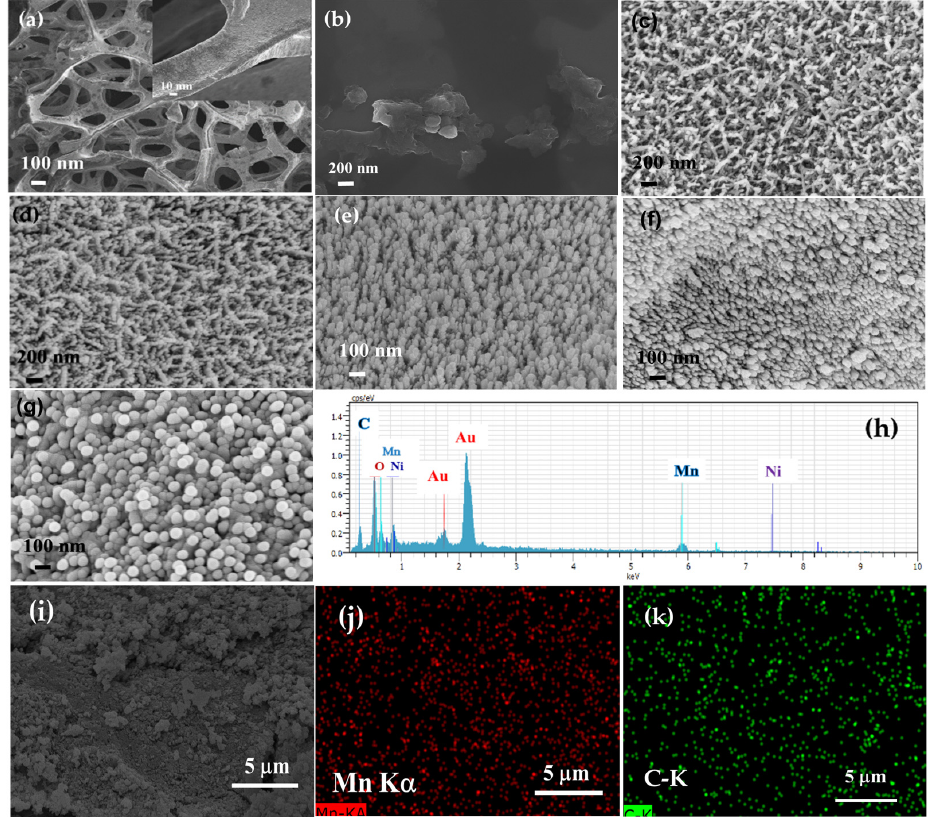
Figure 1. FESEM images of Ni foams ( a ), graphene/Ni foams ( b ), MnO 2 /graphene/Ni electrode (1 mA cm − 2 ( c )), MnO 2 /graphene/Ni electrode (5 mA cm − 2 ( d )), MnO 2 /graphene/Ni electrode (10 mA · cm − 2 ( e )), MnO 2 /graphene/Ni electrode (15 mA cm − 2 ( f )), and MnO 2 /graphene/Ni elec- trode with the current of 1 mA cm − 2 for 30 min deposition ( g ). EDX spectrum of MnO 2 /graphene/Ni electrode with current of 1 mA cm − 2 for 30 min deposition ( h ). FESEM image of MnO 2 /graphene/Ni electrode and both Mn and C mapping of MnO 2 /graphene/Ni material ( i – k